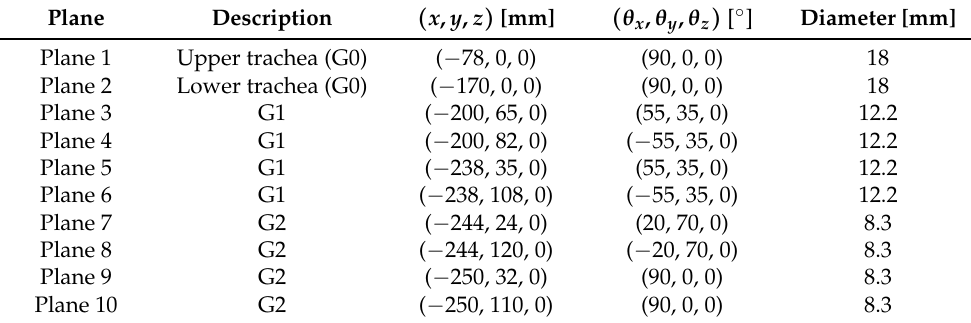
Table 2. Location of Planes used for data analysis and corresponding sectional airway